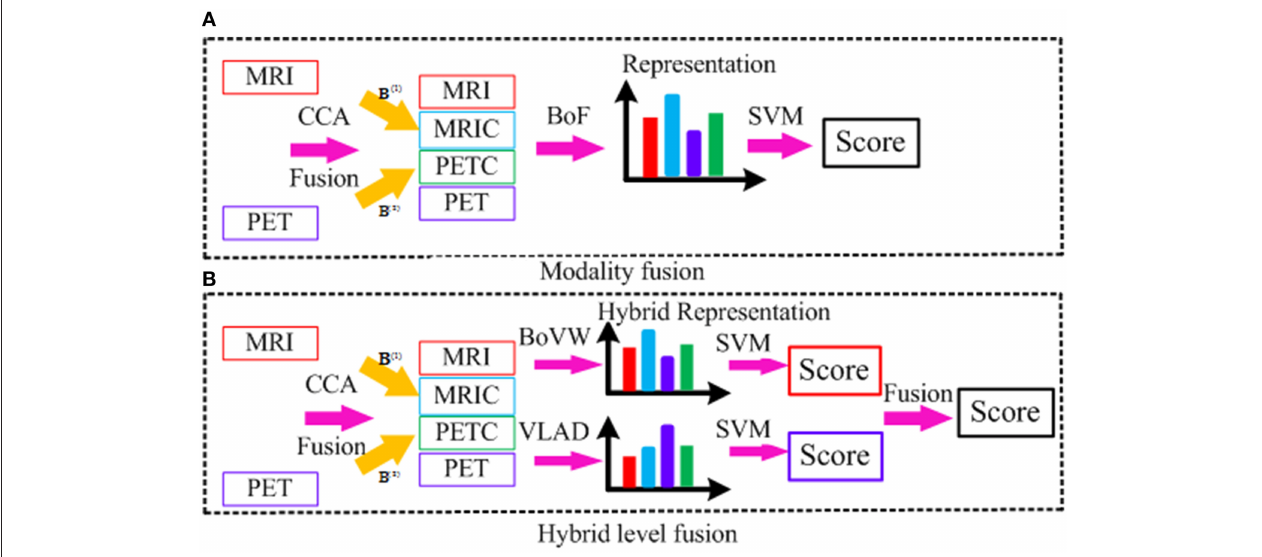
FIGURE 5 | Illustration of different fusion methods; (A) modality fusion; (B) hybrid level